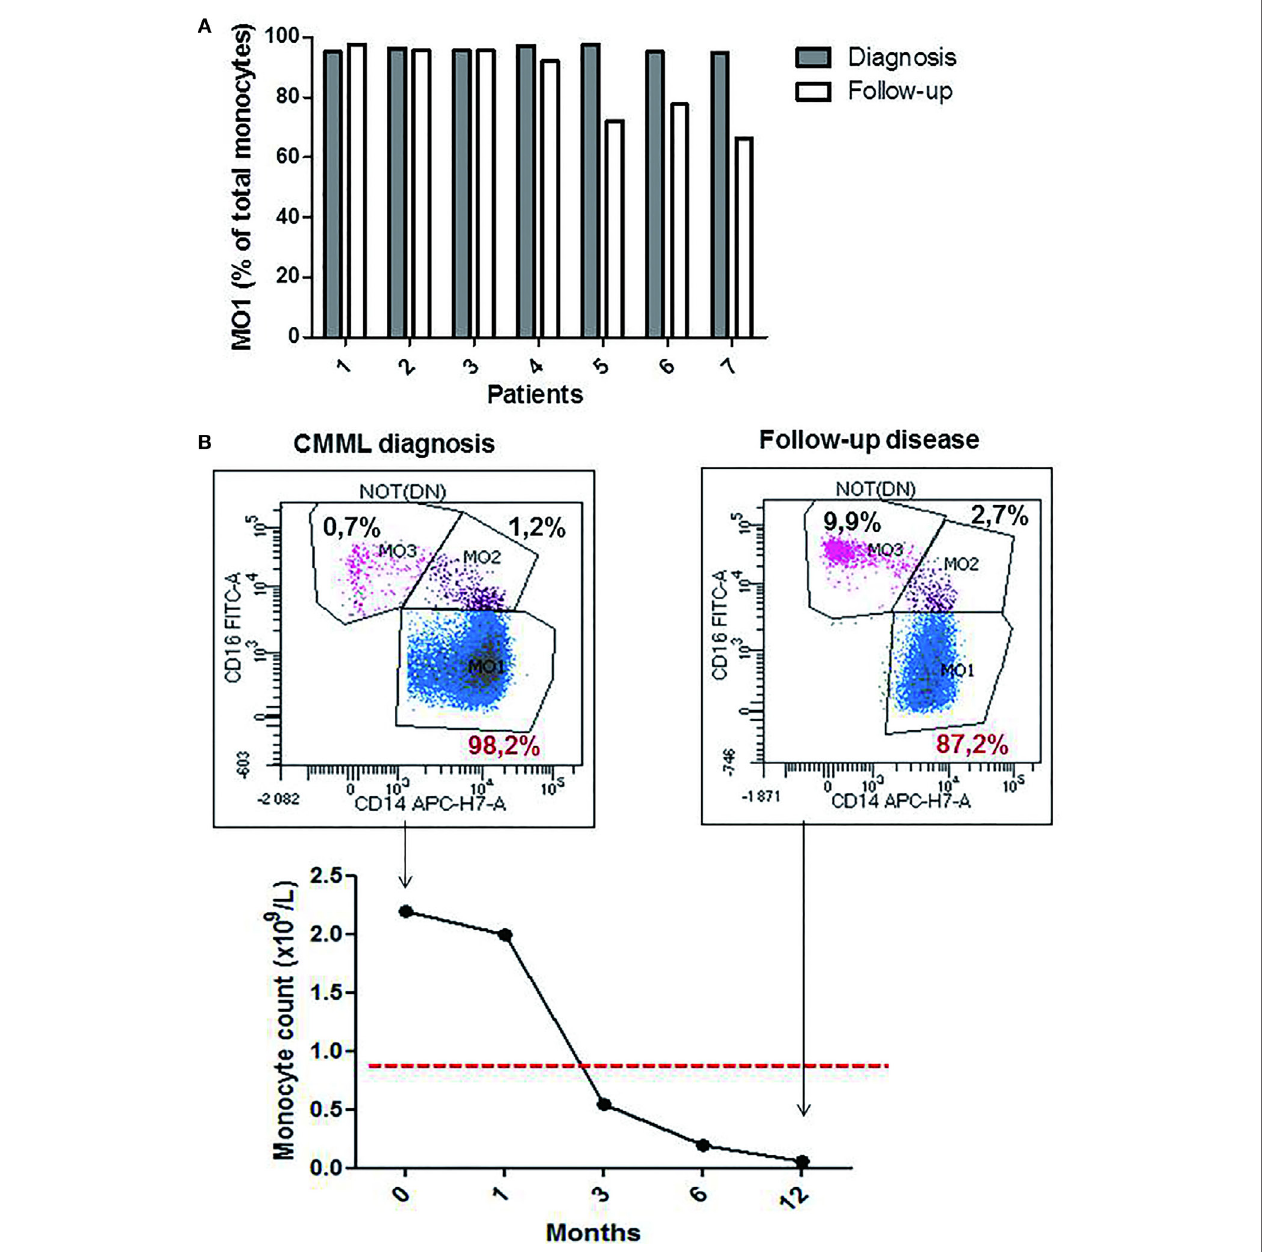
FigUre 4 | The profile of the monocytes subsets during chronic myelomonocytic leukemia (CMML) follow-up. Relative frequencies of the MO1 subsets at the diagnosis point (dark bar) versus follow-up (white bar) ( n = 7 CMML patients). MO1 are expressed as a percentage of total monocytes (a) . Representative example for the evolution of % MO1 classical monocytes during the follow-up in a CMML case with good response to the hypomethylating agents therapy (B)